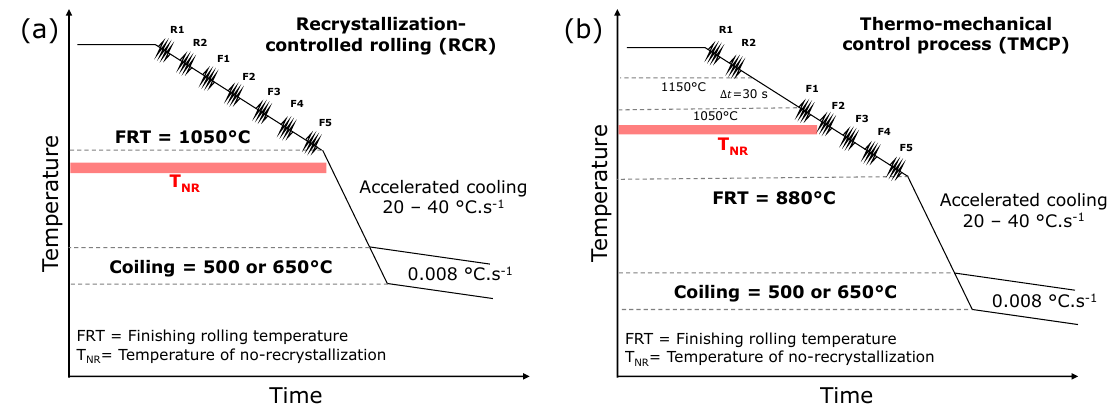
Figure 6. Schematic hot rolling schemes performed on pilot plant : ( a ) Recrystallization-controlled rolling (RCR) and ( b ) Thermo-Mechanical Control Process (TMCP). For each hot deformation scheme, two different coiling temperatures of 500 and 650 ◦ C were applied, giving a total of four different hot rolling